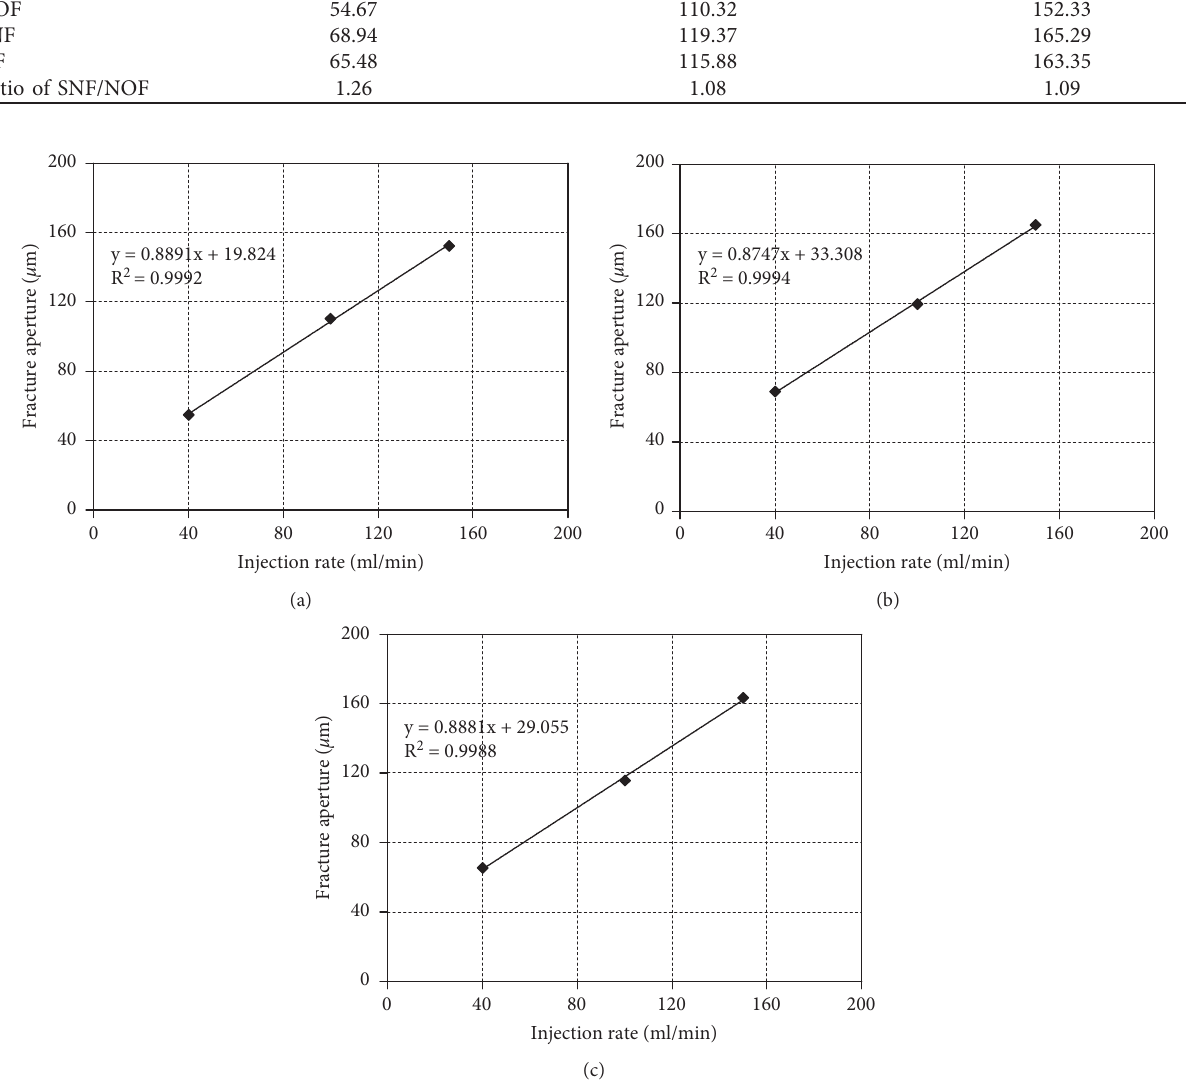
Figure 6: Relation between injection rate and fracture aperture: (a) relation between injection rate and average aperture of NOF; (b) relation between injection rate and average aperture of SNF; (c) relation between injection rate and average aperture of